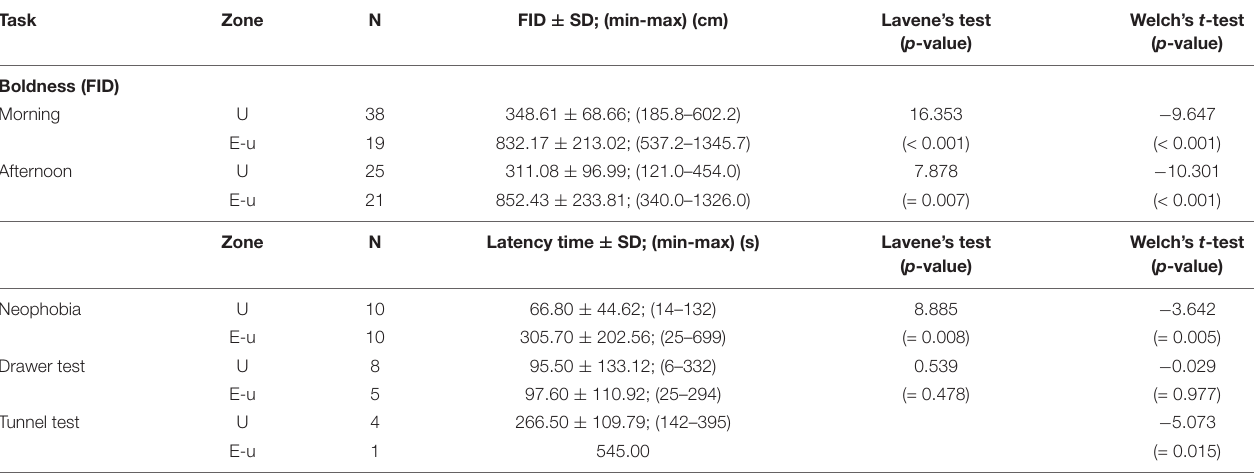
TABLE 1 | Characteristics of the behavioral performance in boldness, neophobia and two problem- solving tests carried out with individuals of Chiguanco Thrush from urban (U) and extra-urban (Eu) zones of the city of La Paz.